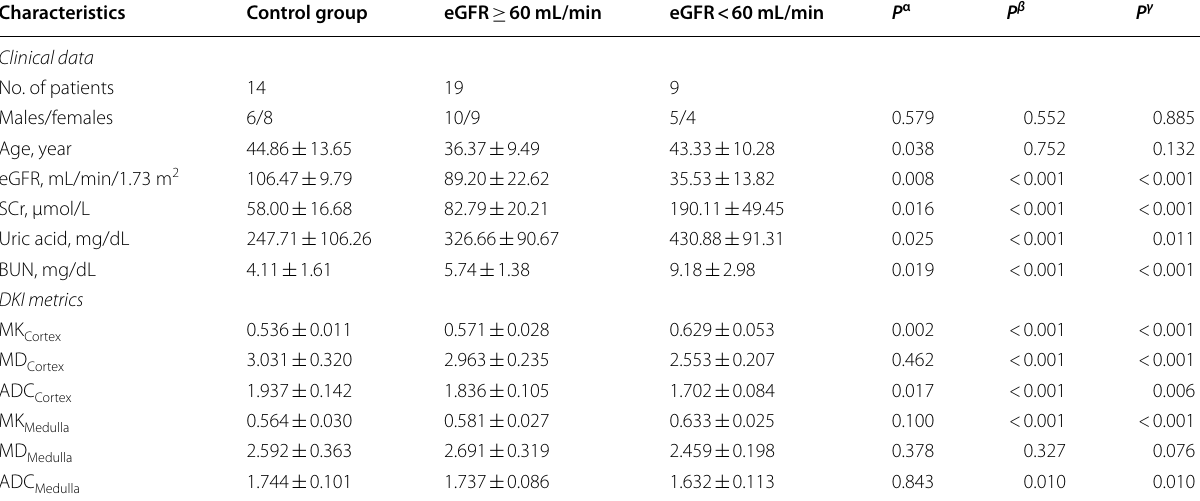
eGFR, estimated glomerular filtration rate; SCr, serum creatinine; BUN, blood urea nitrogen; MK, mean kurtosis; MD, mean diffusivity; ADC, apparent diffusion coefficient α Represents the comparison of parameters between control group and eGFR β Represents the comparison of parameters between control group and eGFR < 60 mL/min γ Represents the comparison of parameters between eGFR